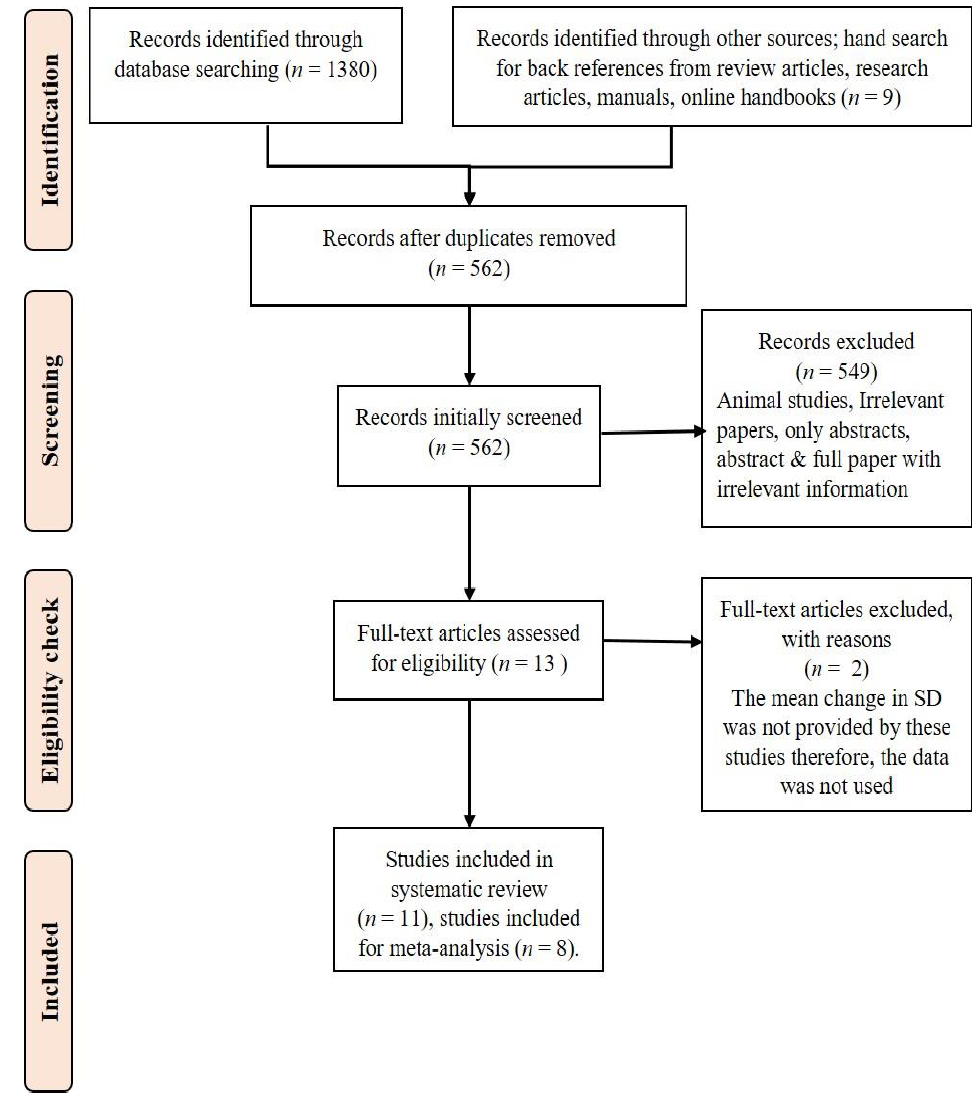
Figure 1. PRISMA flow diagram for the systematic review.